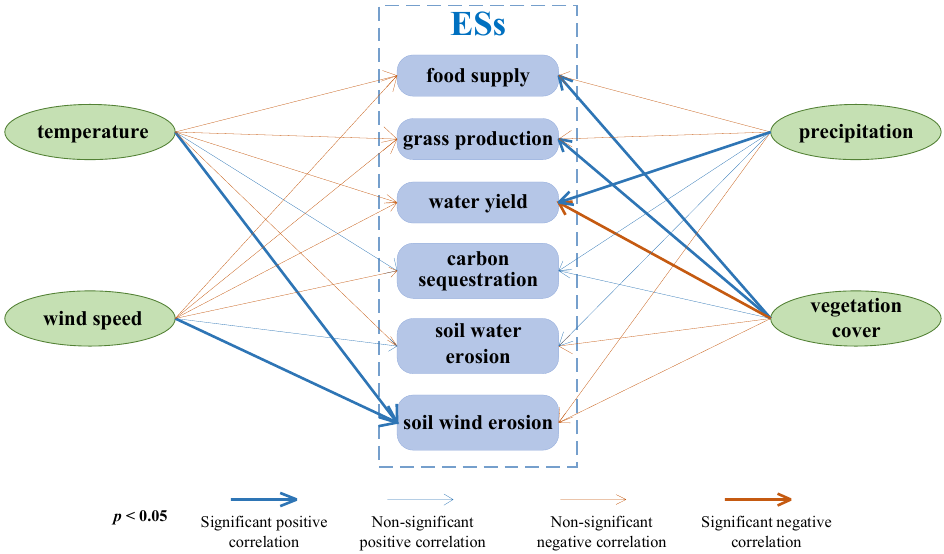
Figure 10. Visualization of the correlation between temporal changes in ecosystem services and drivers (precipitation, temperature, wind speed, vegetation cover) from 2000 to 2017.